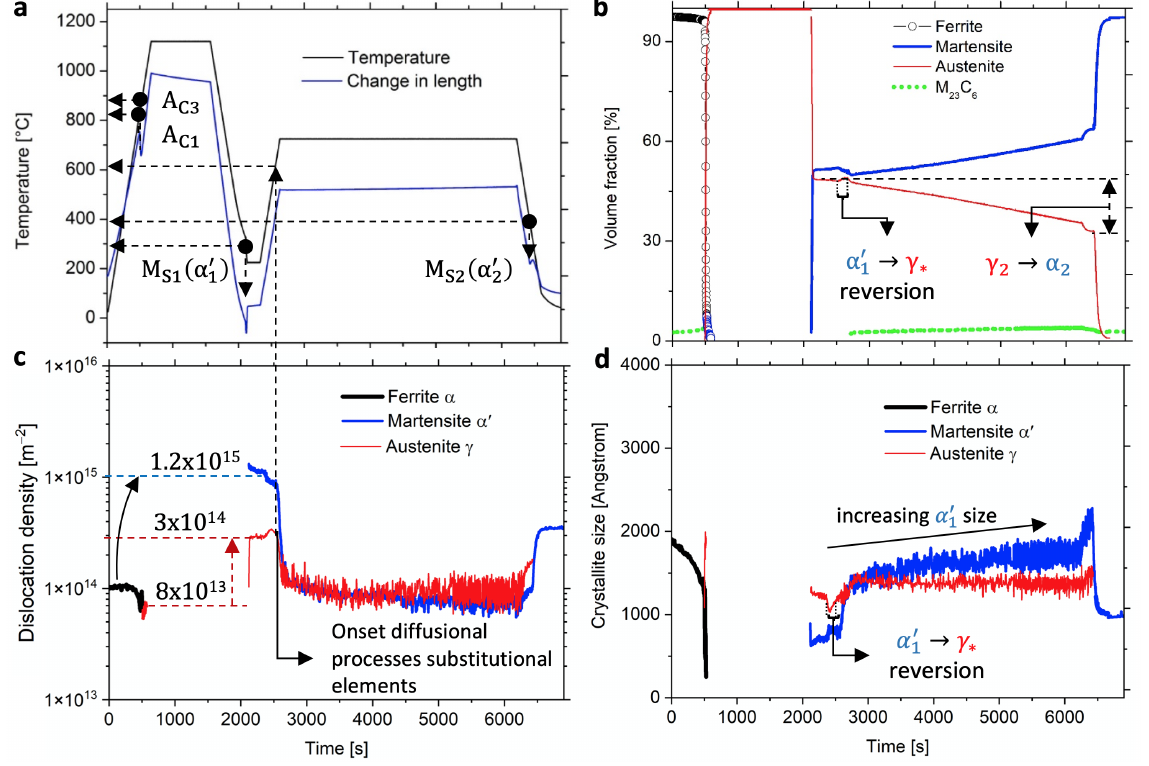
Figure 2. The Q&P heat treatment (HT) applied with the results from the in situ synchrotron radiation experiment combined with dilatometry show the volume fractions of different phases γ , α , α (cid:48) , and M 23 C 6 ; the evolution of the internal dislocation density; and the crystallite size in ( a – d